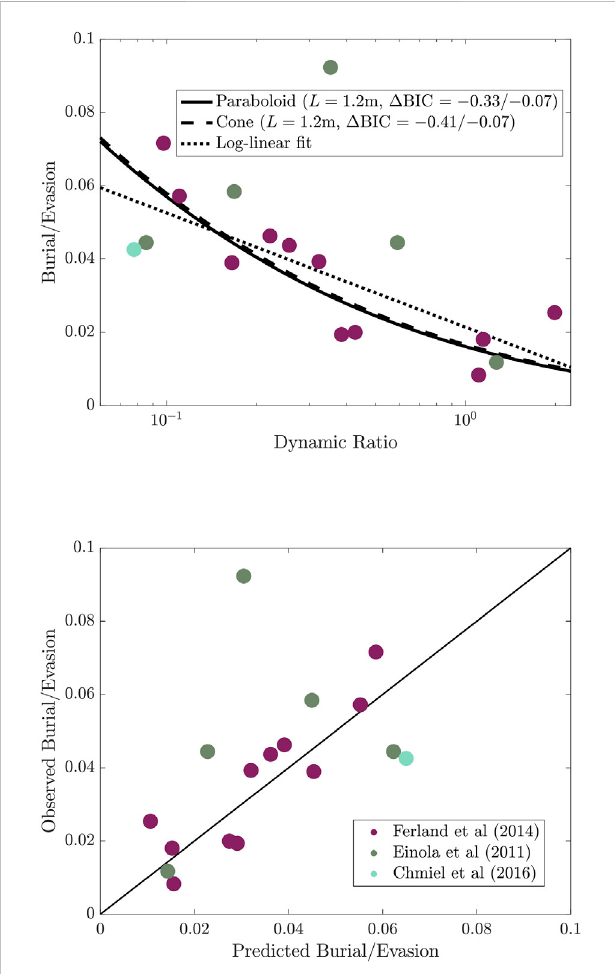
FIGURE 1 Top: Dynamic ratio versus the lake carbon burial/evasion ratio for the theory, an empirical fi t, and observations. The black lines give the theoretical burial/evasion ratio as a function of the dynamic ratio for parabolic (solid) and conic (dashed) lake shapes and for a log-linear empirical fi t to the data. Colored points give empirical results for comparison. L is the free parameter for our theoretical model, which is estimated as L = 1.2 m for both idealized lake shapes. Δ BIC is the difference in the Bayesian information criterion for each theoretical model versus the empirical model (with/without the outlier point above the legend); a negative value indicates that the theoretical model is a better fi t to the data. Bottom: Predicted vs. observed burial/evasion ratios for the conic model with L = 1.2 m. The legend shows the study corresponding to each data